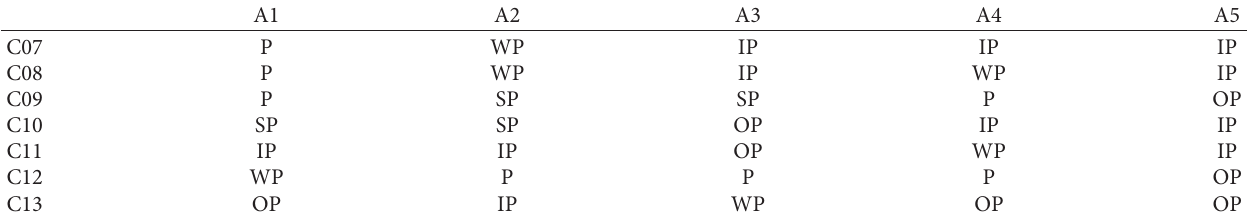
Table 9: Linguistic terms of decision-maker’s viewpoint in economic criteria.